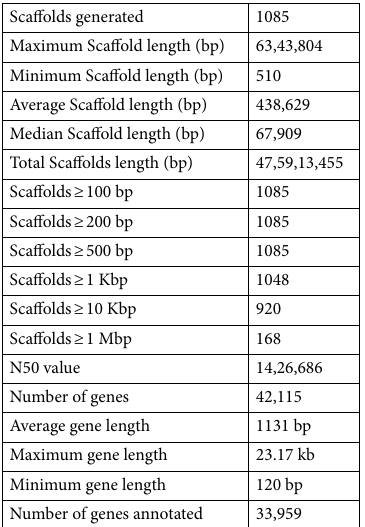
Table 1. De novo assembly and annotation statistics of the blackgram